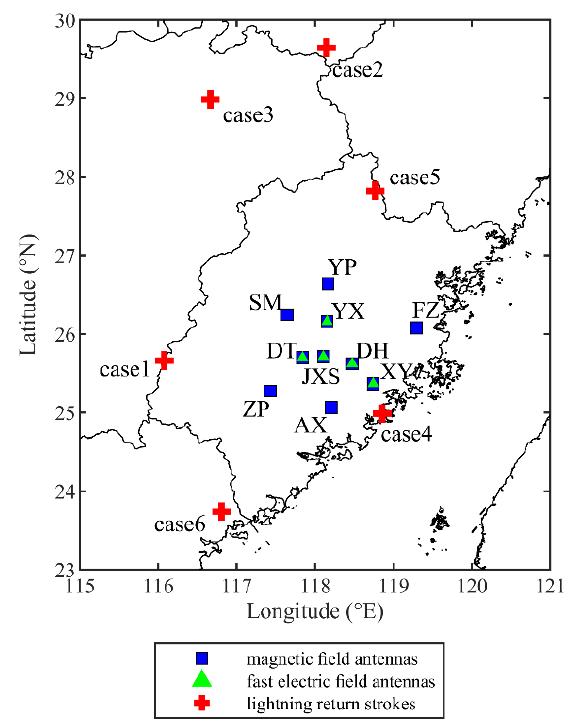
Figure 2. Sensor locations within the lightning locating network in Fujian Province. The blue squares mark the magnetic field antennas. The green tringles mark the fast electric field antennas. The red crosses mark the lightning return strokes (case 1 to case 6) whose position is estimated by using 10 stations (9 stations for case 2 and case 3) simultaneous waveforms data.